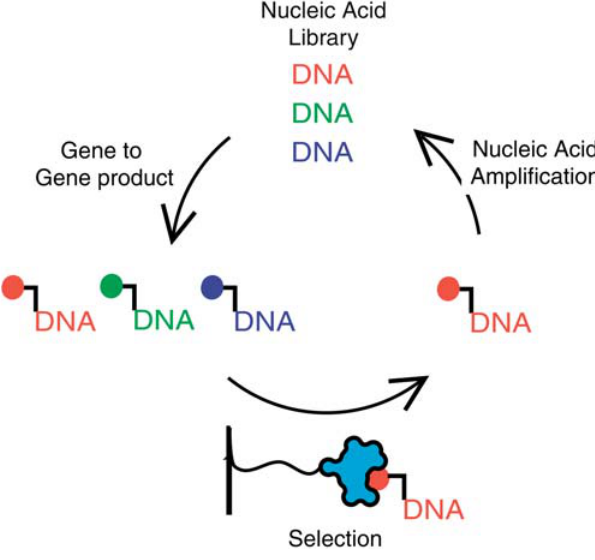
Figure 1. The In Vitro Selection Cycle Experiments are initiated with a nucleic acid library (colored DNA). The sequence of each gene directs the synthesis of a corresponding gene product (colored ball) that is physically linked to its encoding nucleic acid. The gene products are subjected to selection, for example, through binding to an immobilized macromolecule (cyan widget at bottom). The nucleic acid encoding selected gene products is amplified and used as input for a subsequent cycle. DOI: 10.1371/journal.pbio.0020174.g001